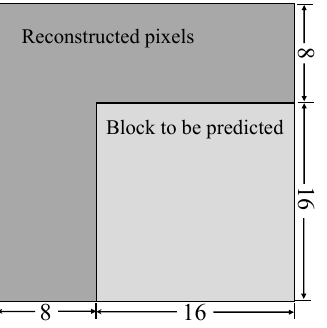
Figure 3. Illustration of the input to the generator.